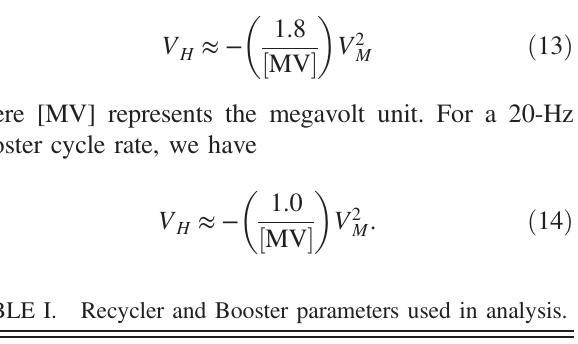
TABLE I. Recycler and Booster parameters used in analysis. Recycler Kinetic Energy ( E ) 8 GeV Recycler Reference rf freq. ( f 0 ) 52.8 MHz